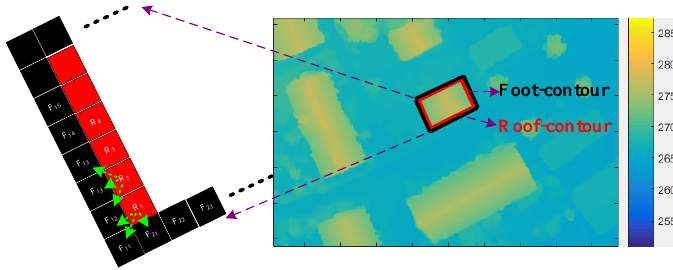
Figure 4. Height estimation.